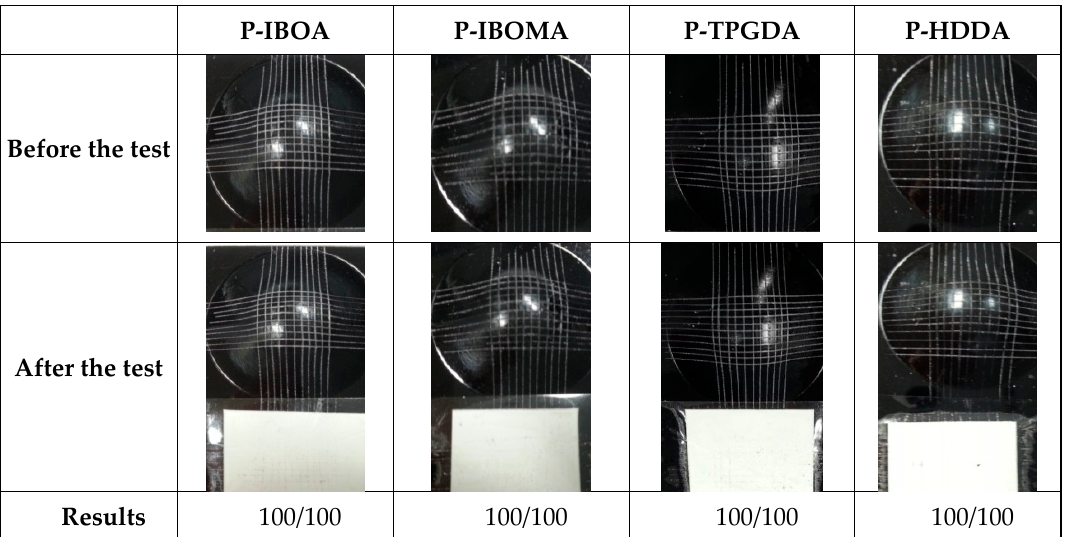
Figure 7. Cross-cutter Erichsen test (C.C.E.T) of UV-cured PUA coating films.